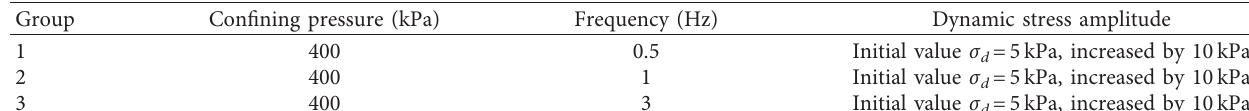
Table 2: Dynamic loading test scheme of mudstone sample.